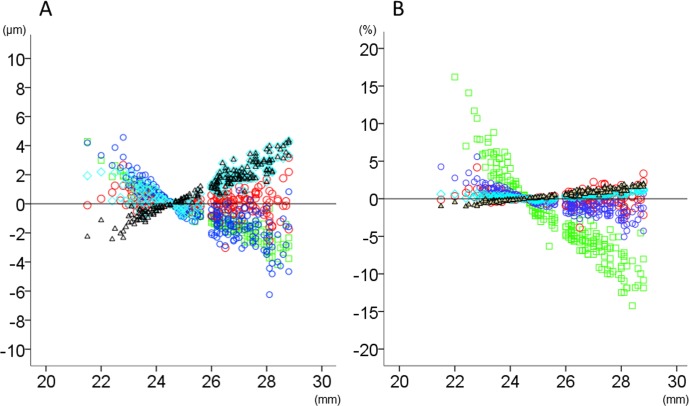
The relationship between axial length and thickness changes of retinal layers in the inner ring of analytical area after magnification correction.The thickness changes (μm; A) and relative thickness changes compared to the magnification-uncorrected thickness (%; B) after magnification correction were plotted against axial length. Green squares: retinal nerve fiber layer, Red circles: ganglion cell layer plus inner plexiform layer, Blue circles: ganglion cell complex, Light blue diamonds: total retina, Black triangles: outer retina.